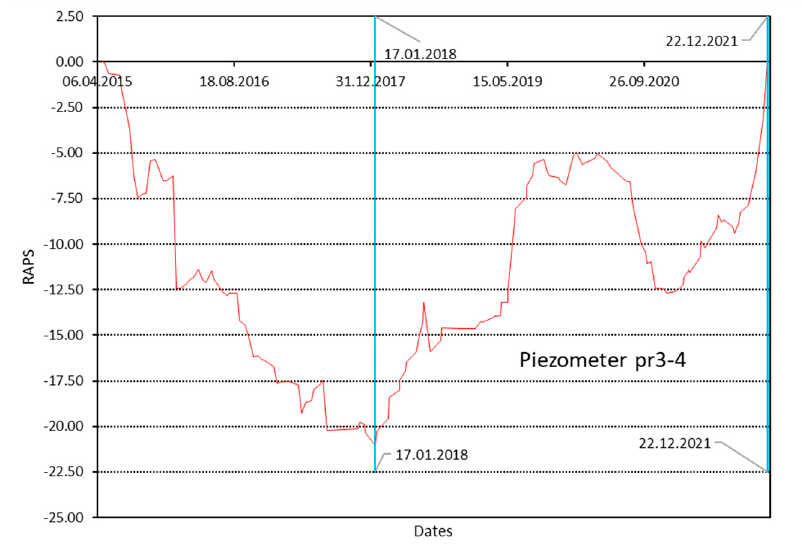
Figure 14. RAPS values for piezometer PR3/2.